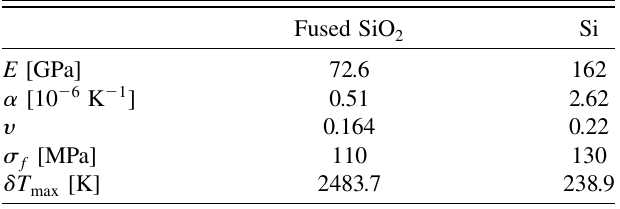
Thermomechanical properties of fused silica and silicon [50].